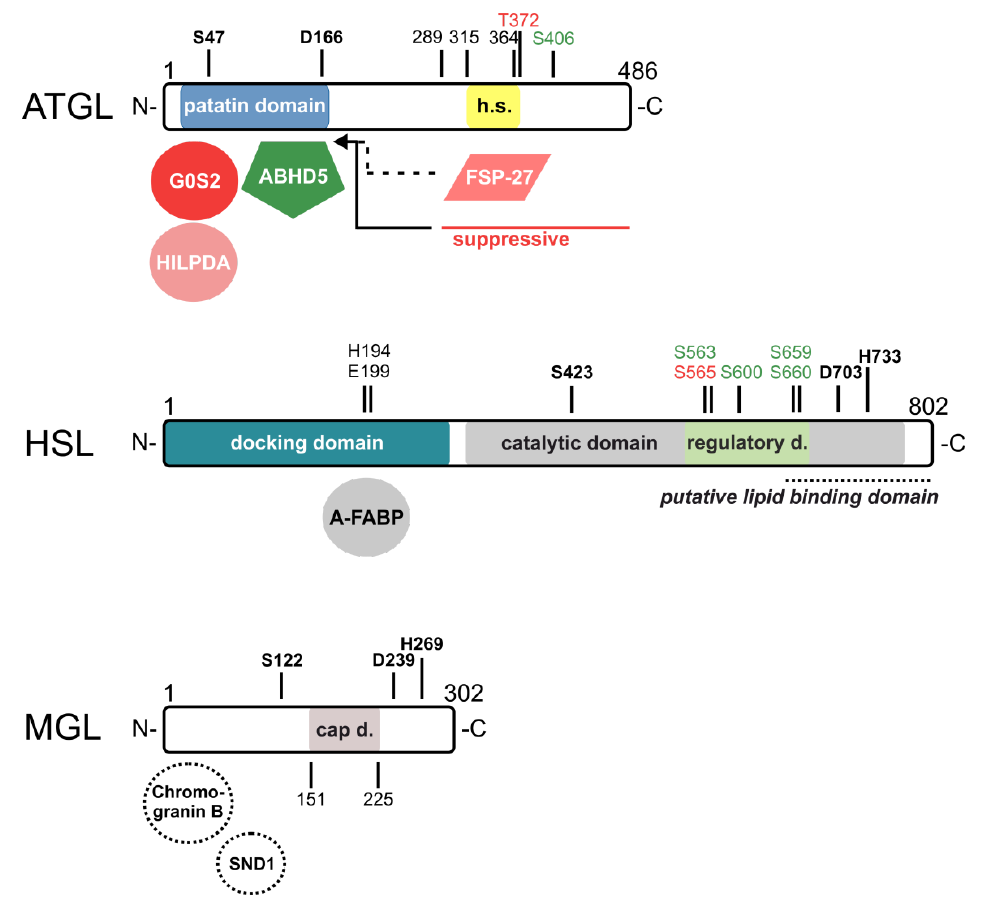
Figure 3. Domain structures and identified sites of (putative) interaction partners of ATGL, HSL, and MGL. For murine ATGL, the catalytic dyad consists of S47 and D166 within the patatin domain at the N-terminus. This domain serves as a docking domain for the co-activator alpha/beta-hydrolase domain containing protein 5 (ABHD5) and the inhibitors G0/G1 switch gene 2 (G0S2) and hypoxia-inducible LD-associated protein (HILPDA) of ATGL. At the C-terminus, ATGL contains a hydrophobic stretch (h.s.) from amino acids 315–364 that is essential for lipid droplet (LD) localization. The phosphorylation of T372 abrogates LD localization and that of S406 increases the enzymatic activity of ATGL. The C-terminus from amino acids 289–486 suppresses enzymatic activity and might interfere with ABHD5 interactions. Fat-specific protein-27 (FSP27) possibly interferes with LD localization or with ABHD5 interaction (dashed lines). For murine HSL, the N-terminus serves as a docking domain for interaction partners. Adipocyte-type fatty acid-binding protein (A-FABP) binds to amino acids 192–200, with H194 and E199 being critical for interaction. The C-terminal domain contains the catalytic domain (grey) consisting of S423, D703, and H733, and within that, a regulatory domain (light green) with five phosphorylation sites that regulate HSL localization and activity, and a putative lipid binding domain (italics, dashed line). For human MGL, the active site consists of S122, D239, and H269, and the cap domain (grey) covering the active site that stretches from amino acids 151 to 225. Putative binding partners that may regulate activity or protein expression are indicated by dashed circles (SND1, Staphylococcal nuclease and tudor domain containing 1). Amino acids of the catalytic sites are highlighted in bold. Co-regulators/amino acids that activate enzyme activity are highlighted in green; those who inhibit enzyme activity are highlighted in red color tones.